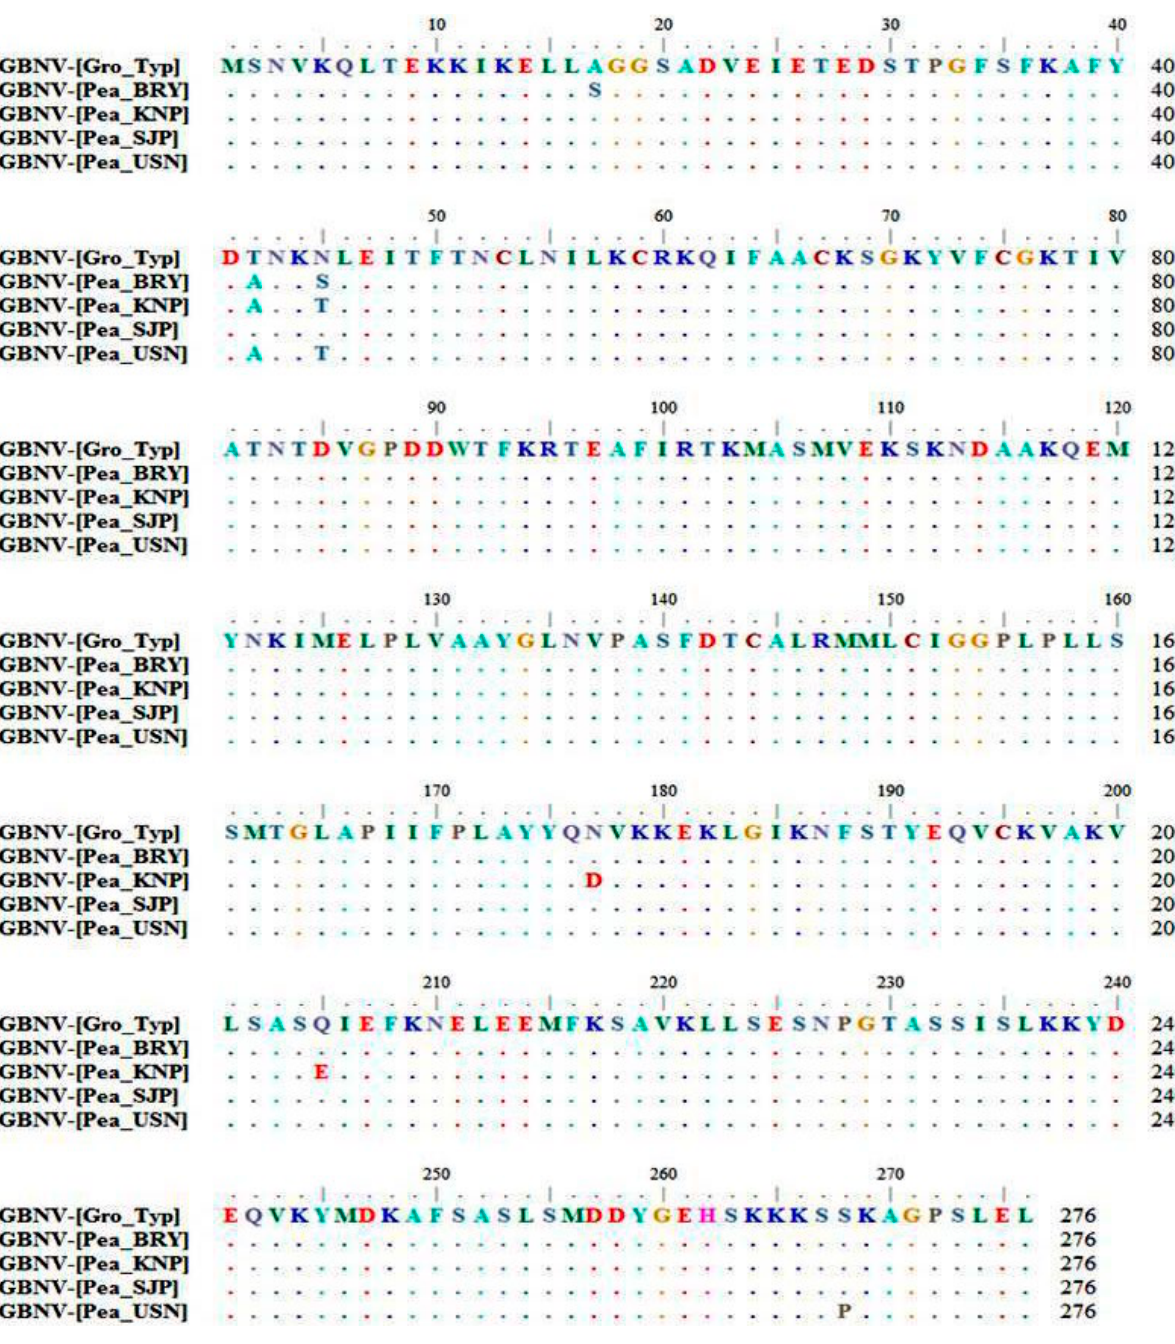
Figure 3. Multiple alignment of NP gene of GBNV isolates of Pea under study and Type isolate of GBNV. Dot indicates the similar amino